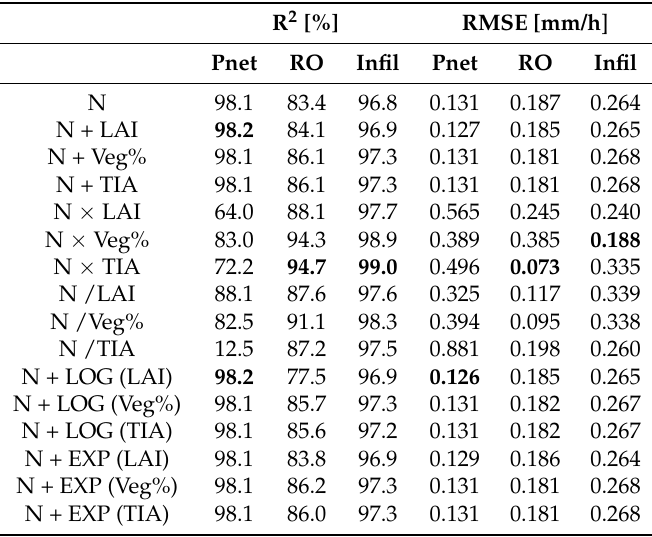
Table 3. Linear regression for Pnet, polynomial regression of RO and Infil , sample number n = 46,059, N being P for the calculation of Pnet respective Pnet for the runoff and infiltration process. The best performance measures are in